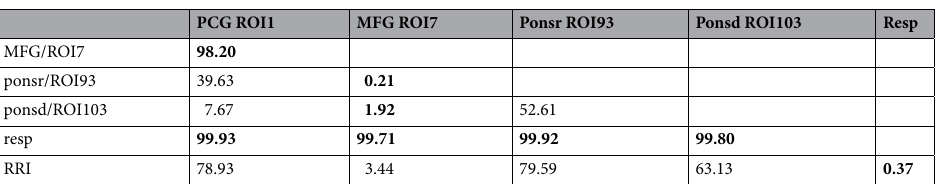
Table 2. Differences between in- and outflows in terms of percentiles of the distribution obtained by the bootstrap approach for the HA group. For further explanation, see Table 1. Significant differences (marked by bold numbers) are those which exceed the region of 95% of the random distribution of the differences obtained by the bootstrap method. Depending on the sign of the differences between inflows and outflows, they are located below 2.5 and above 97.5